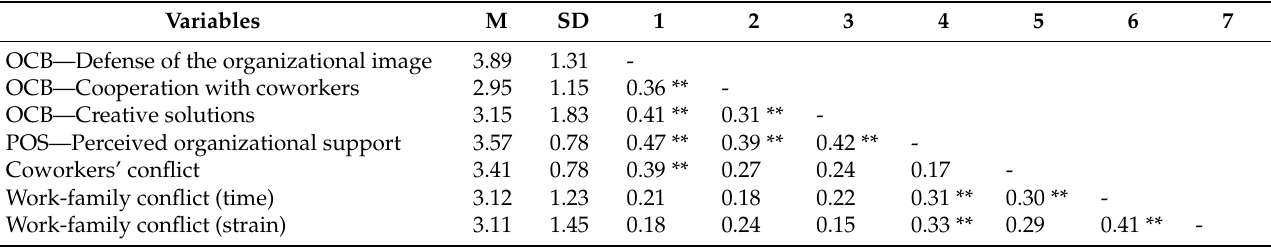
Table 1. Means and Standard Deviations and